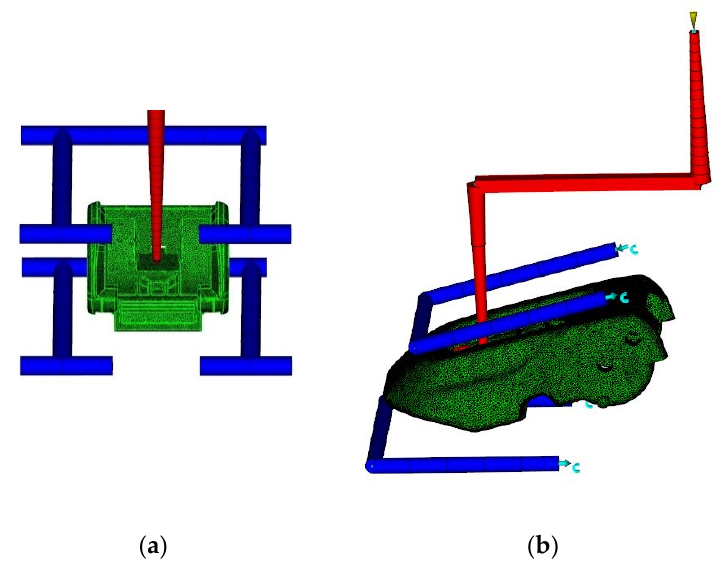
Figure 3. Runner system for analysis. ( a ) Pivot sub-assembly. ( b ) Open lever.